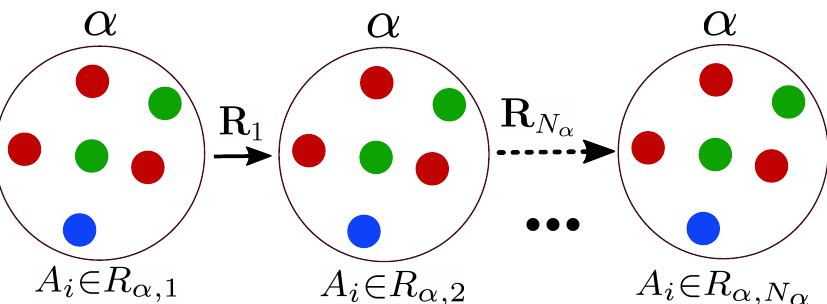
Figure 1. Schematic representation of the main parameters included in the factor δ i , j calculated by the Equation (4). Multicolored circles are atoms; one color specifies a certain kind of atoms. If the arrangement of atoms in the system is repeated—first, second, etc. up to N α large circles, this sets the symmetry α , and R 1 , R 2 , . . . R n , . . . , R N are radius vectors setting the position of 1,2, . . . , n α , . . . , N α α α large circles. For example, the symmetry with α = 1 is represented in this figure, and with α = 2 the location, color, number of circles inside the big circle, number of big circles, and R n be